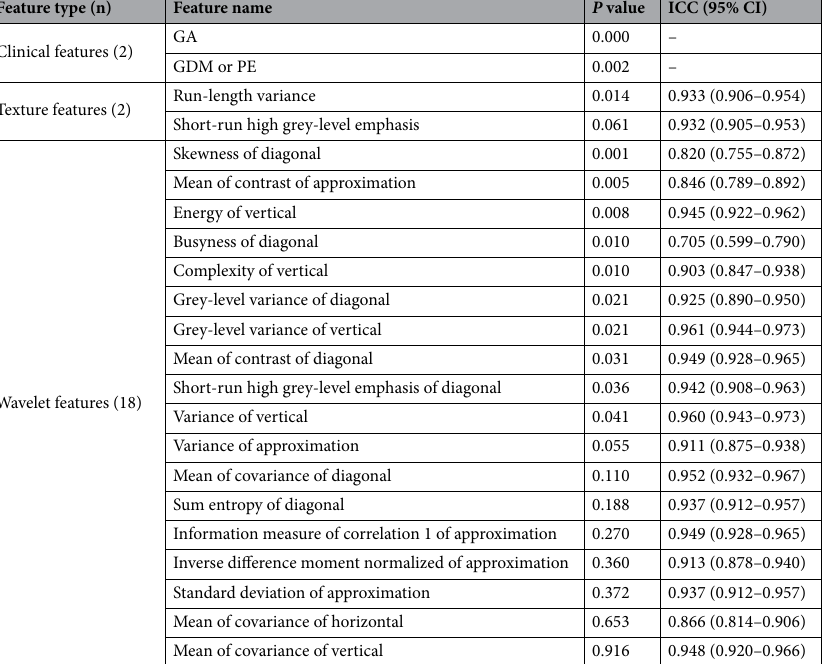
Table 4. List of high-throughput sonographic features. Between the normal group and the NRM group, T-test was performed for each feature. P value < 0.05 indicated a significant difference. The smaller the P value,